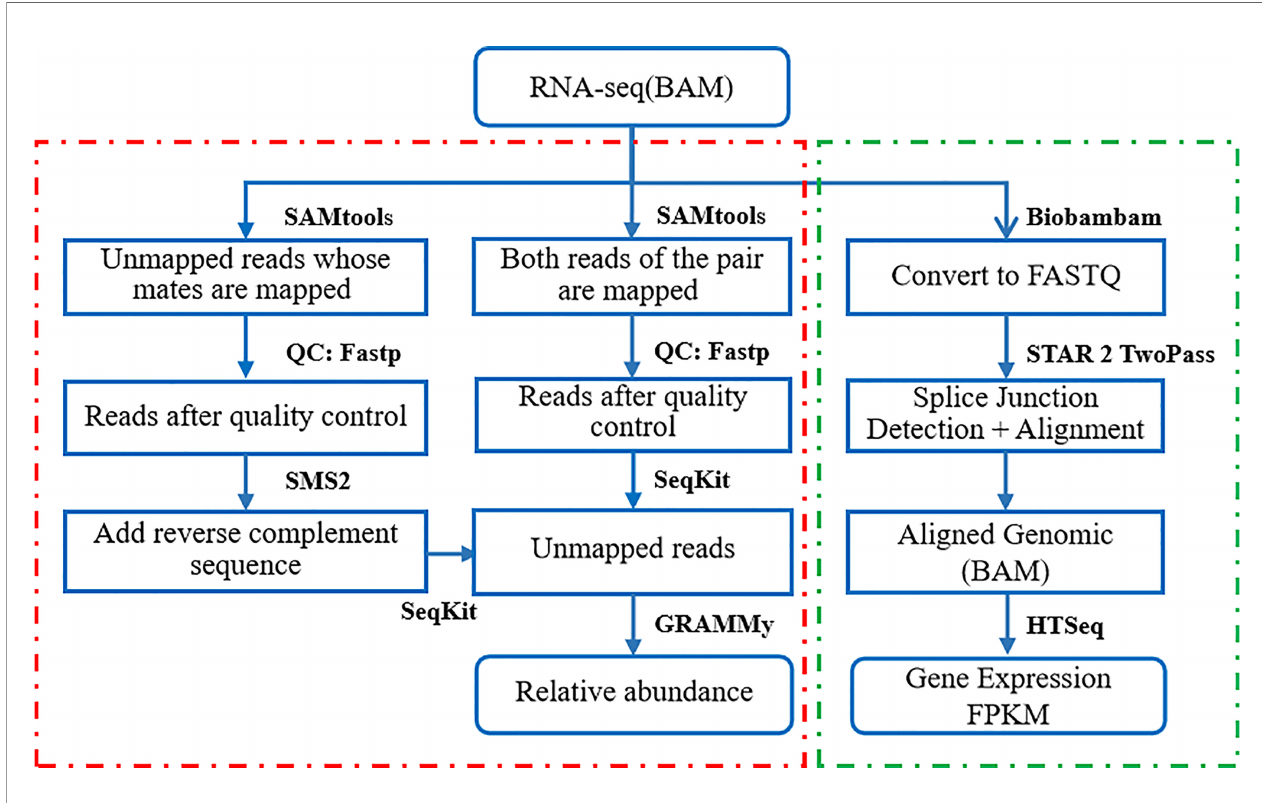
FIGURE 1 | Flow chart of RNA-Seq sequencing data